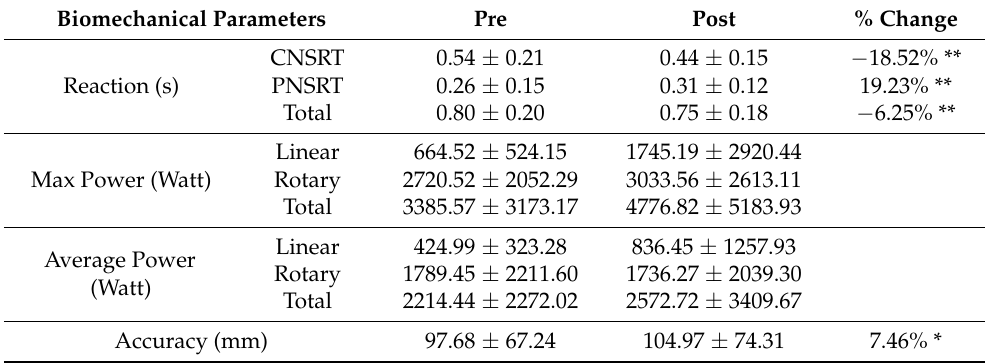
Table 4. Results of the overall effects of weight